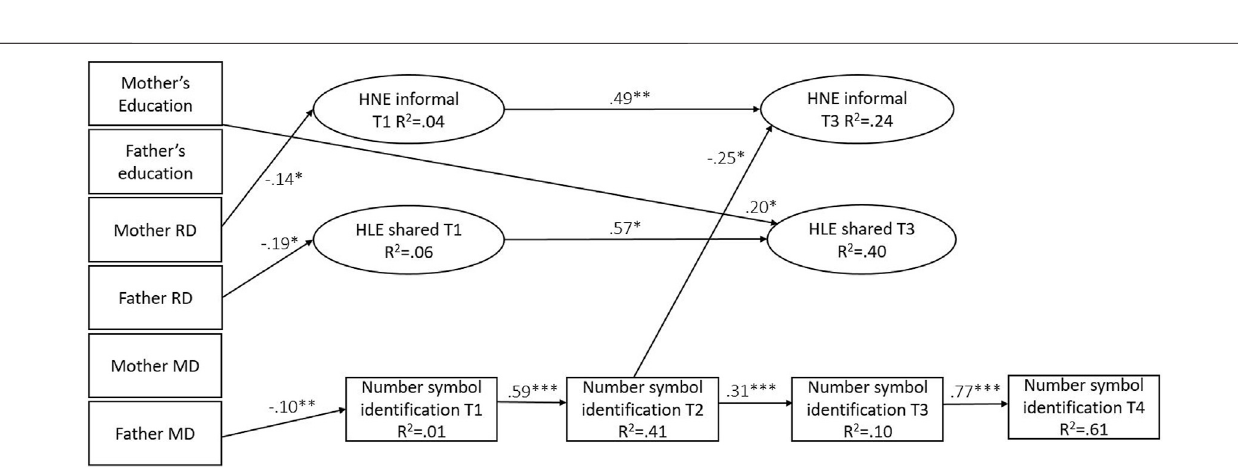
FIGURE 6 | The model for number sequence skill with the signi fi cant standardized estimates. Note . In addition to the regression paths depicted, there were two signi fi cant residual correlations: between HNE and HLE at T1 (stand. estimate (cid:1) 0.38***) and between HNE and number sequence skill at T1 (stand. estimate (cid:1) 0.35**).